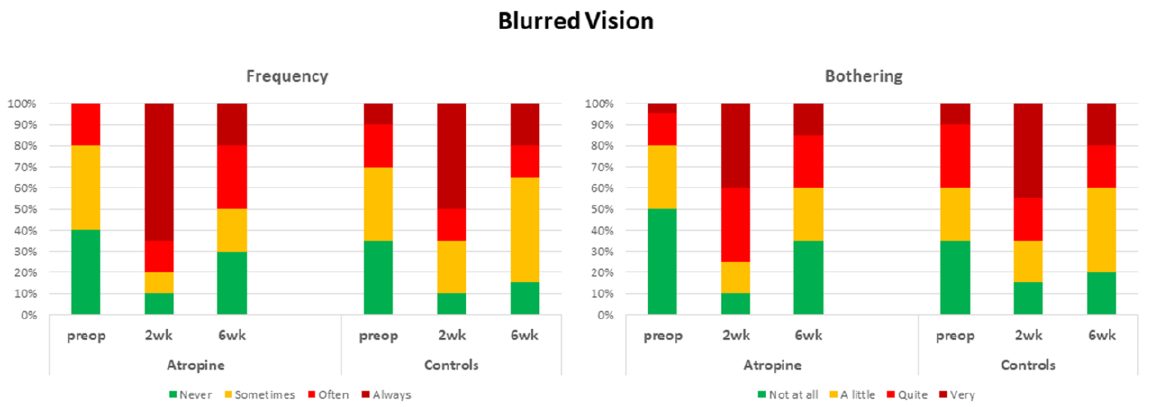
Figure 3. Frequency and bothersomeness of blurred vision reported by both groups. The percentage of patients given each possible value is presented. In both groups, there is an increase in the frequency and bothersomeness of blurred vision two weeks after surgery. Whereas these effects were corrected in the control group, in the atropine group, frequency and bothersome of blurred vision remained significantly high.